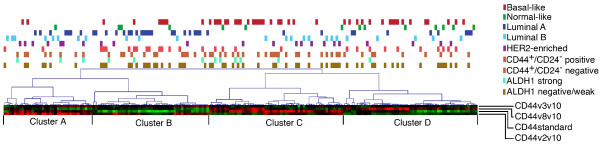
Hierarchical clustering of breast tumors based on CD44 isoform expression resulted in four main clusters. The heatmap shows relative mRNA expression levels (red, high; green, low). Tumors in Cluster C and D were associated to the basal-like molecular subtype and cluster B was associated to luminal A-classified tumors. Cluster B and D had the highest proportions of tumors of the CD44+/CD24- phenotype.